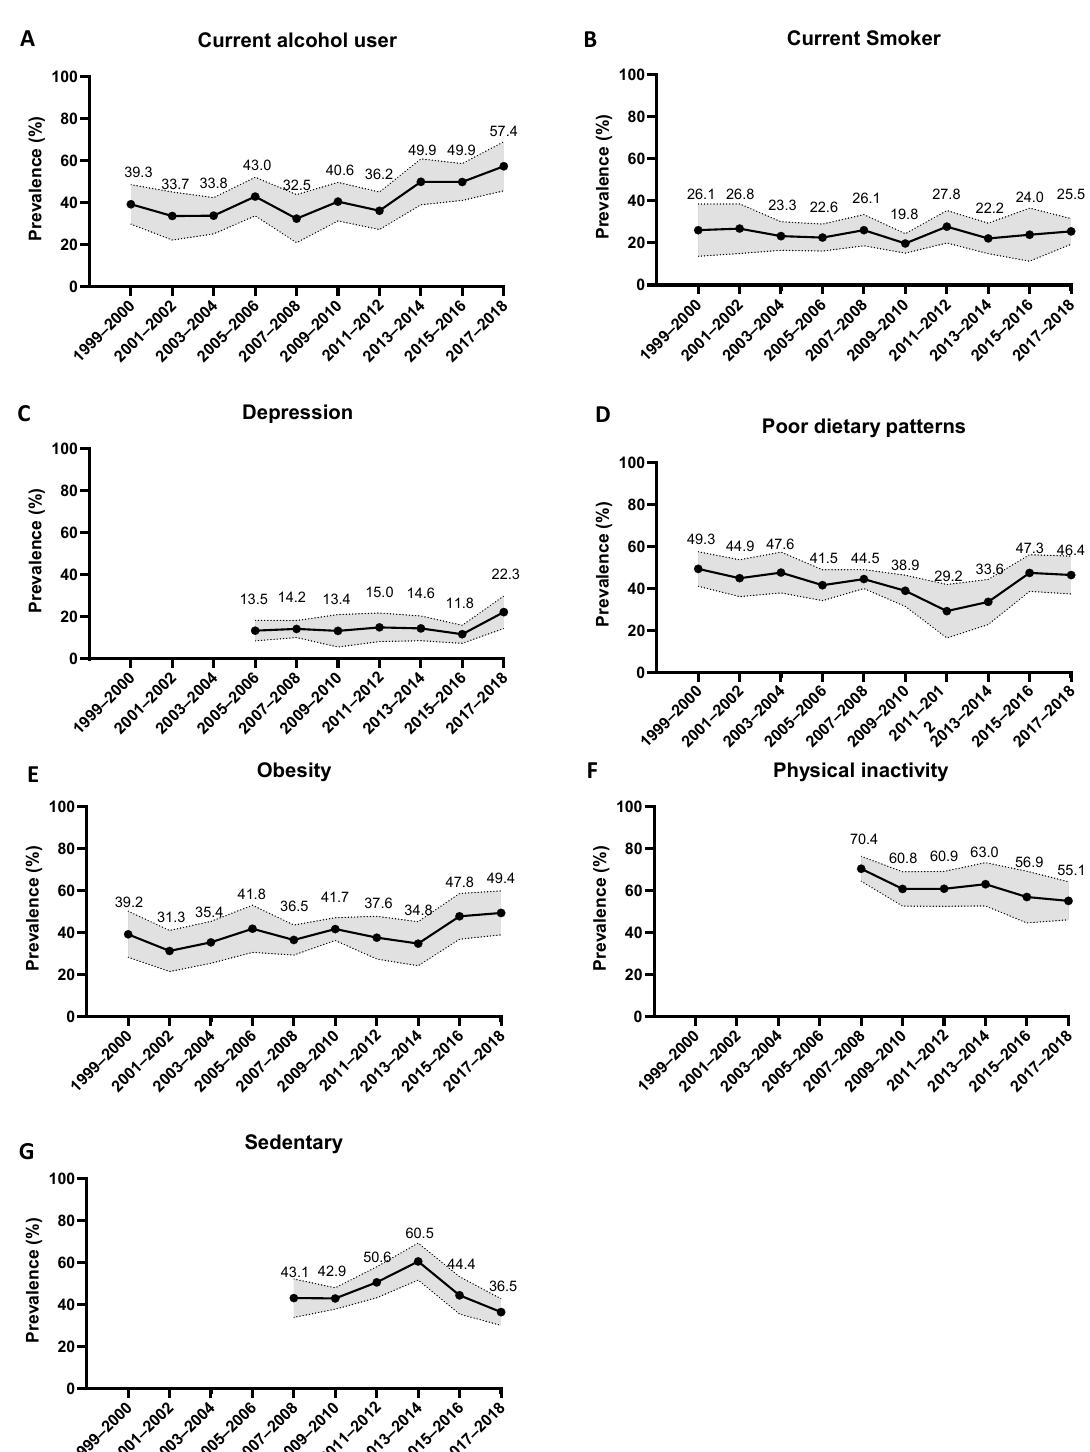
1999–2000 2001–2002 2003–2004 2005–2006 2007–2008 2009–2010 2011–2012 2013–2014 2015–2016 2017–2018 Figure 2. Age-Standardized Trends in Prevalence of Unhealthy Lifestyles among U.S. Adults with a History of Stroke, 1999–2018. Showed as trends for current alcohol drinking ( A ), smoking ( B ), depression ( C ), poor diet ( D ), obesity ( E ), physical inactivity ( F ) and sedentary behavior ( G ). Shaded areas indicate 95% confidence intervals. Representative information for depression was available in the NHANES only from 2005–2006 through 2017–2018. Representative information for the physical inactivity and sedentary factors was available in the NHANES only from 2007–2008 through 2017–2018. NHANES, National Health and Nutrition Examination Survey. Smoking prevalence remained similar across the surveys. The age-adjusted esti- mated prevalence was 26.1% (95% CI: 13.7 to 38.6) in 1999–2000 and 25.5% (19.4 to 31.6) in 2017–2018, with an AAPC of 0.3% ( − 3.1 to 3.8; p = 0.865). The prevalence of current alcohol drinking significantly increased from 39.3% (29.8 to 48.7) to 57.4% (45.7 to 69.0) over the same period, with an AAPC of 4.9% (1.6 to 8.2; p = 0.008). Depression increased non-significantly from 2005–2006 to 2017–2018 (13.5% (8.6 to 18.4) 22.3% (14.6 to 30.0)), with an AAPC of 4.4% (95% − 4.7 to 14.4; p = 0.277) and with most of the increase occurring from 2015–2016 (11.8% (7.4 to 16.1)). The prevalence of unhealthy diets (AHA Secondary score <32) declined significantly, from 44.5% (32.4 to 56.5) in 1999–2000 to 29.0% (17.5 to 40.4) in 2011–2012 (APC: − 5.9% ( − 10.1 to − 1.5); p = 0.019), but then returned to the previous level in 2017–2018 (42.0% (31.4 to 52.7); APC: 9.0% ( − 7.1 to 28.1); p = 0.225). Obesity in- creased from 39.2% (28.3 to 50.2) in 1999–2000 to 49.4% (38.9 to 59.8) in 2017–2018, with an AAPC of 3.4% (0.4 to 6.4; p = 0.029). The prevalence of physical inactivity gradually de- creased between 2007–2008 and 2017–2018 (70.4% (64.4 to 76.3) to 55.1% (46.1 to 64.2)), with an AAPC of − 4.5% ( − 7.5 to − 1.3; p = 0.017). Conversely, the prevalence of sedentary behavior non-significantly increased from 43.1% (34.0 to 52.2) in 2007–2008 to 60.5% (51.7 to 69.3) in 2013–2014 (APC: 14.2% ( − 46.7 to 144.6); p = 0.270) before decreasing to 36.5%